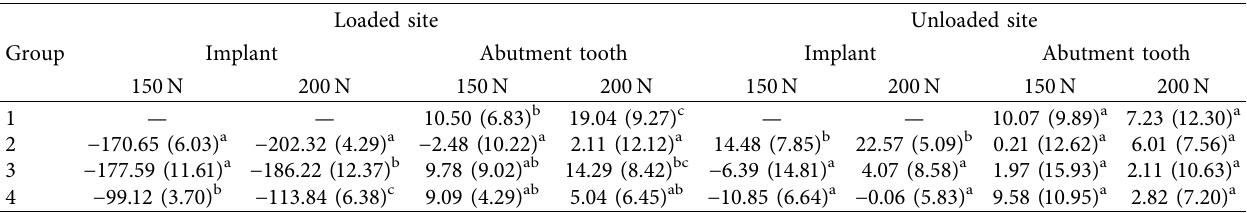
Table 2: Mean microstrain of abutment teeth and dental mini-implants under applied unilateral loading (mean strain values ( ± SD in microstrain)).